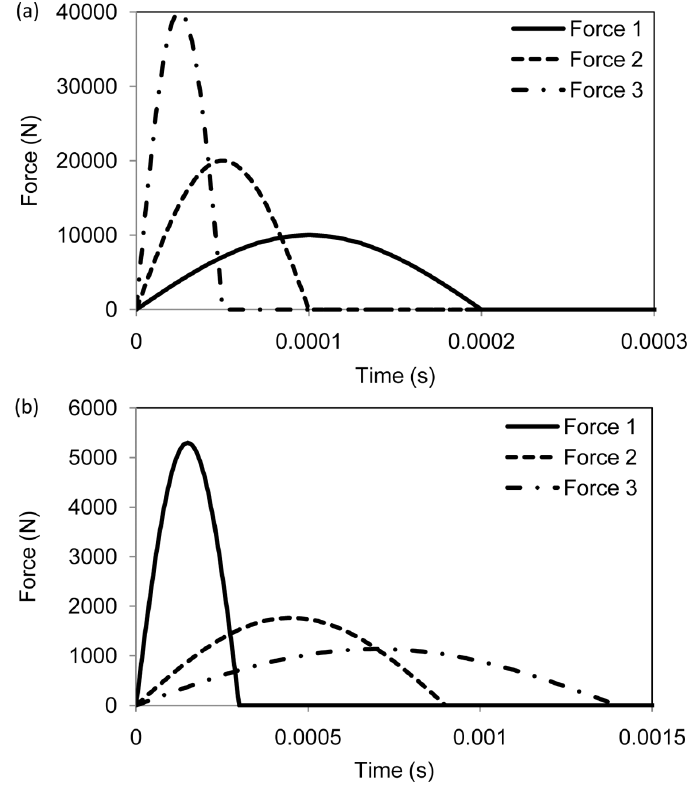
Fig. 13. Applied impact used for (a) short and (b) long structures to study effect of impact